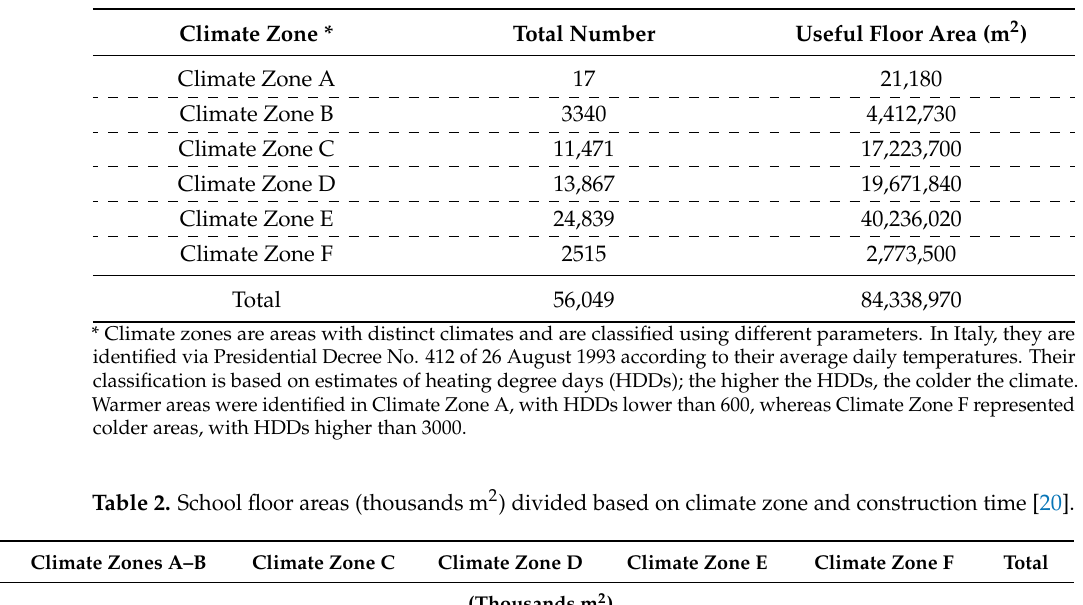
Table 1. Total number of schools and their floor areas, divided based on climate zone [20].